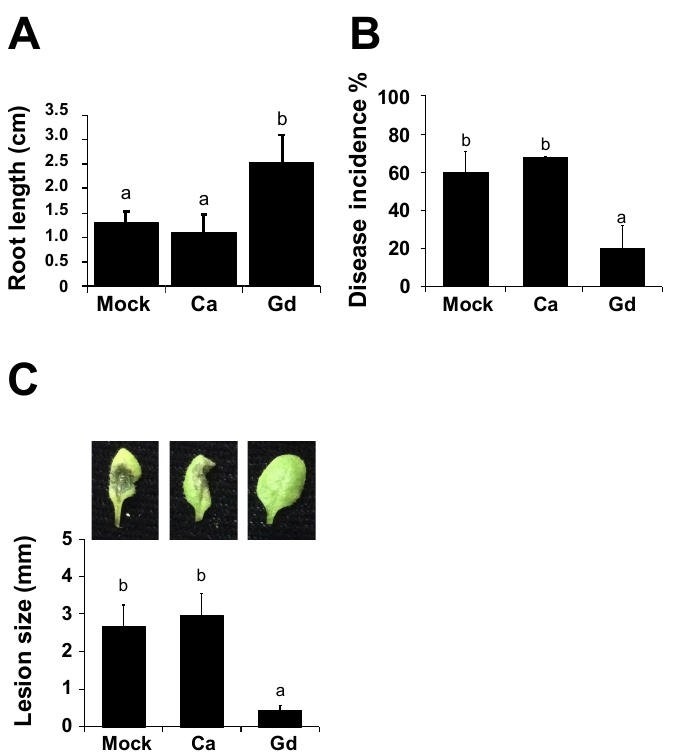
Figure 1. Gd improved the root development of A. thaliana and induced protection against B. cinerea . A. thaliana seeds were incubated for 1 h with distilled sterile water (mock), 0.2 g/L Ca, or Gd and germinated under in vitro conditions. Ten days post germination, the primary root length was measured ( A ). Four-weeks-old A. thaliana plants were sprayed until saturation with distilled sterile water (mock), 0.2 g/L Ca, or Gd (24 hpt). After this, 3 µ L droplets containing a B. cinerea spore suspension (5 × 10 4 spores mL − 1 ) were applied and the 72 hpi disease incidence ( B ) and lesion size ( C ) were evaluated. A representative picture is included above each histogram as a visual illustration. Bars represent mean values ( ± SD) of three independent experiments ( n = 30 for each experiment). Different letters above each bar represent statistically significant differences according to the Scott–Knott test ( p <